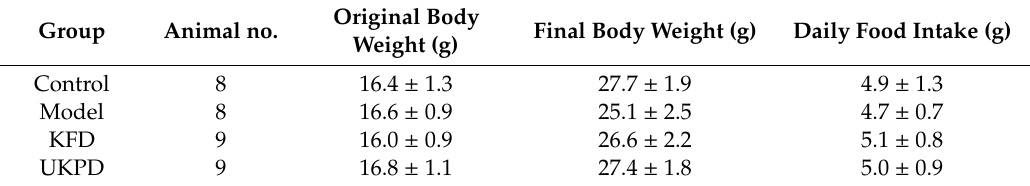
Table 4. E ff ects of UKP on the body weight and food intake of mice. a. Table 4. Effects of UKP on the body weight and food intake of mice. a.